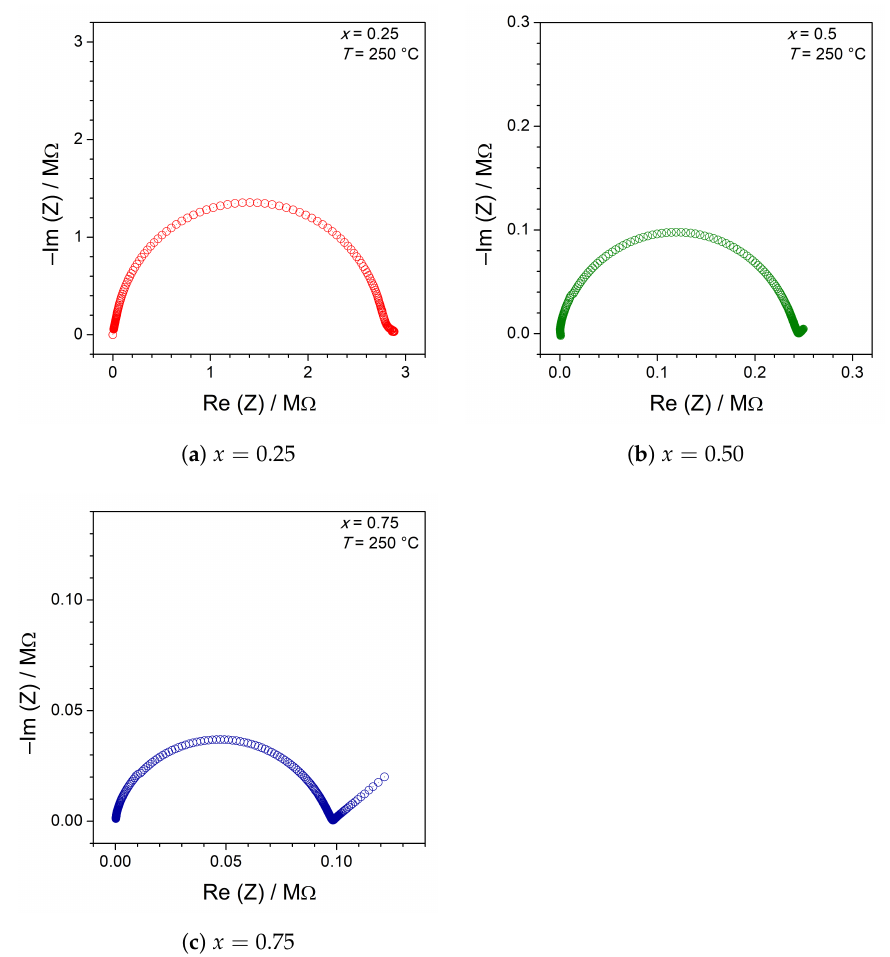
Figure 6. Examples of impedance (Nyquist) plots for selected samples acquired at isothermal conditions at ca. 250 °C upon the heating